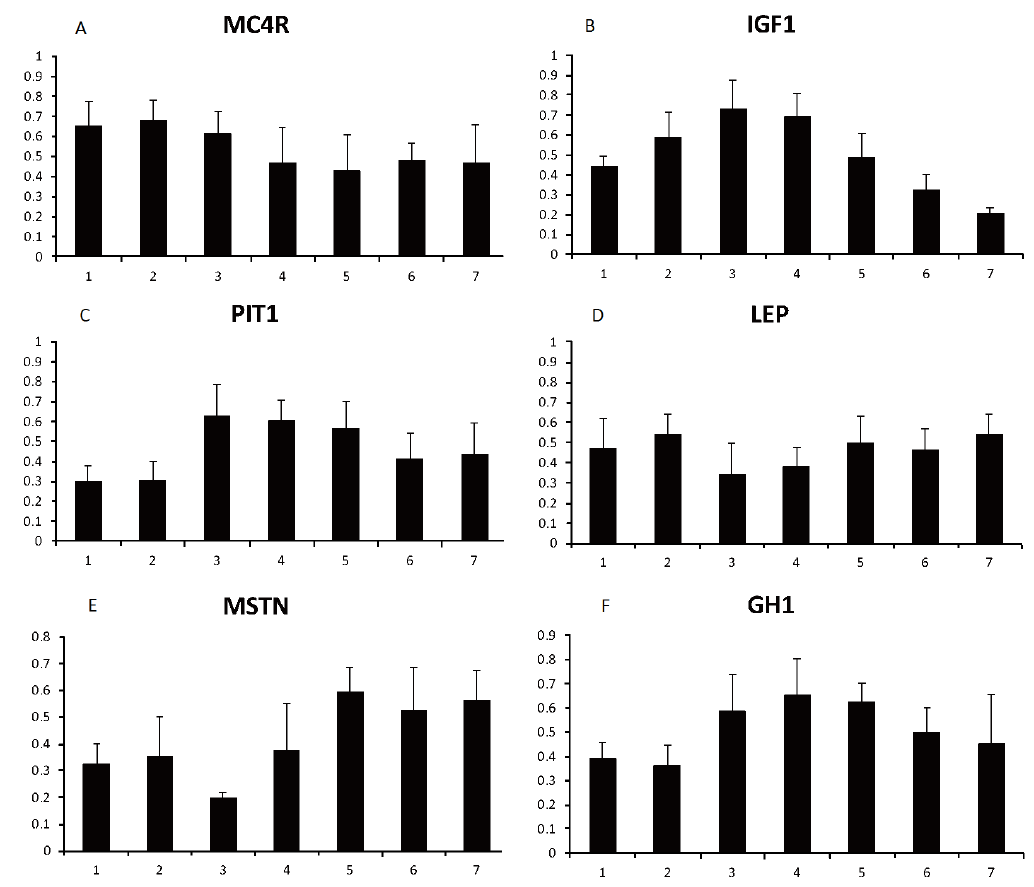
Figure 3. The relative expression level of several genes related to growth and development. (A) The melanocortin-4 receptor ( MC4R ), (B) Insulin-like growth factor I ( IGF1 ), (C) Pituitary specific transcription factor-1 ( PIT1 ), (D) Leptin ( LEP ), (E) Myostatin ( MSTN ), (F) Growth hormone 1 ( GH1 ). Gene expression levels represent the relative mRNA expression compared to the controls. Values represent the mean±standard error, all are normalized by the maximum